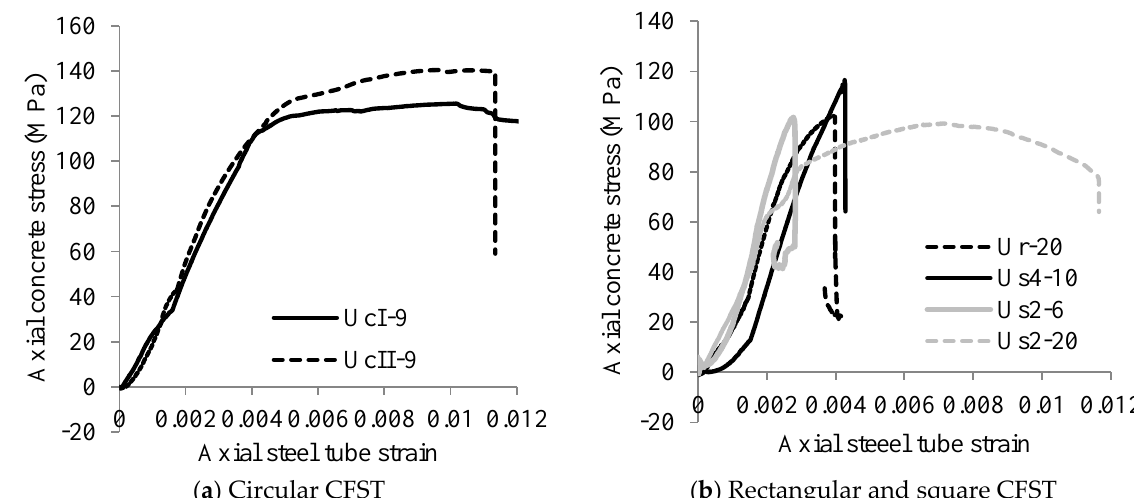
Figure 10. Axial concrete stress vs. steel tube strain development in CFST columns.